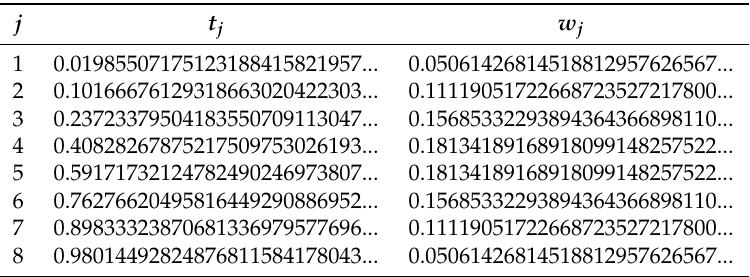
Table 1. Abscissas and weights for k = 8.